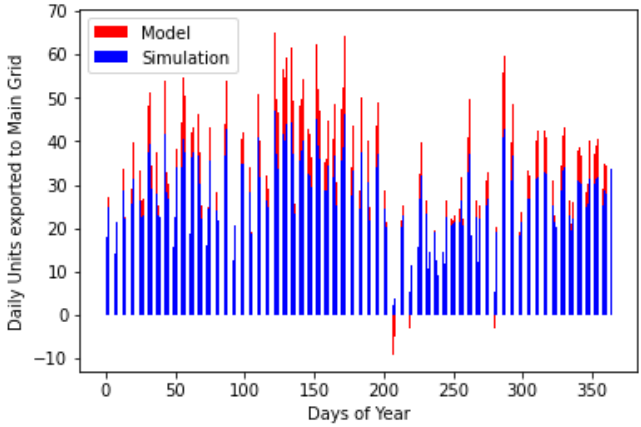
Figure 8. Daily electricity unit savings.